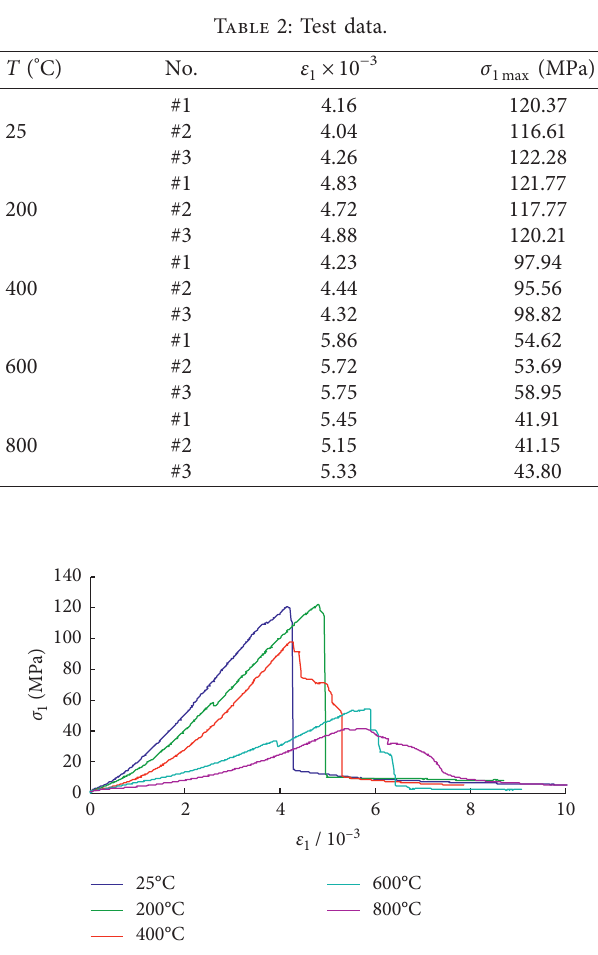
Figure 3: Stress-strain